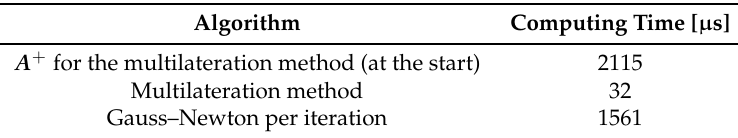
Table 7. Mean computing times of the algorithms used by the UWB-based System. Computing times measured on an STM32F407 running at 168 MHz.